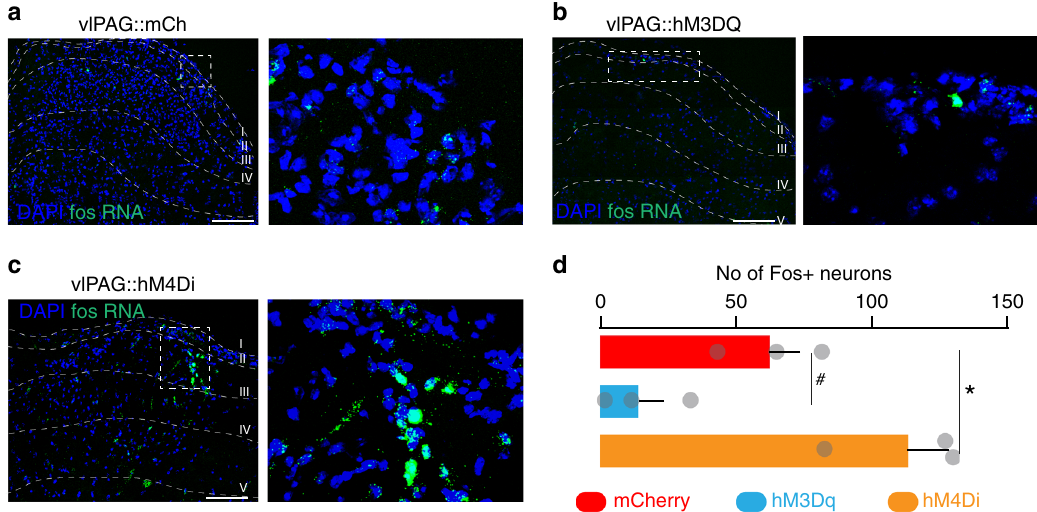
Fig. 9 vlPAG neurons modulates itch-induced activity in spinal cord. FISH analysis of chloroquine-induced cFos expression in the spinal cord in response to CNO in mice expressing hM3Dq, hM4Di, or mCherry control in vlPAG. a Coronal section of spinal cord illustrating c-fos expression